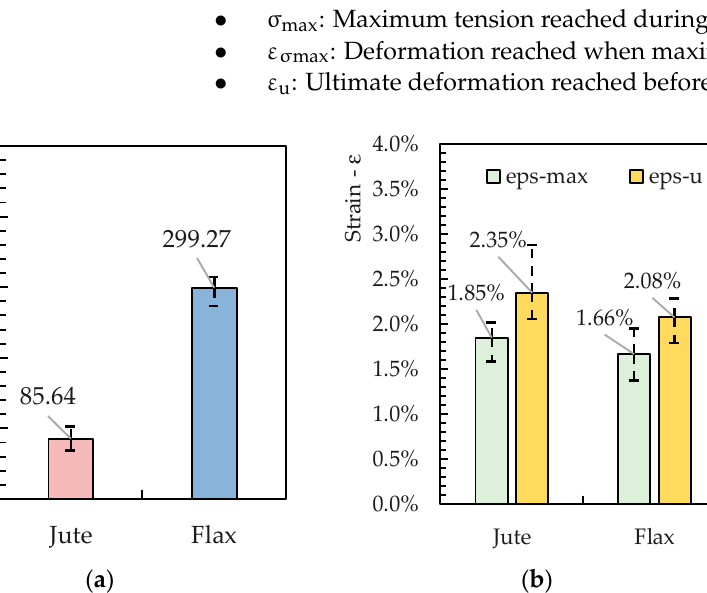
Figure 14. ( a ) Average of the maximum tensile strength, for jute and flax; ( b ) Average of the maxi- mum Young Modulus, for jute and flax; ( c ) Maximum strain and ultimate strain at break for jute and flax.